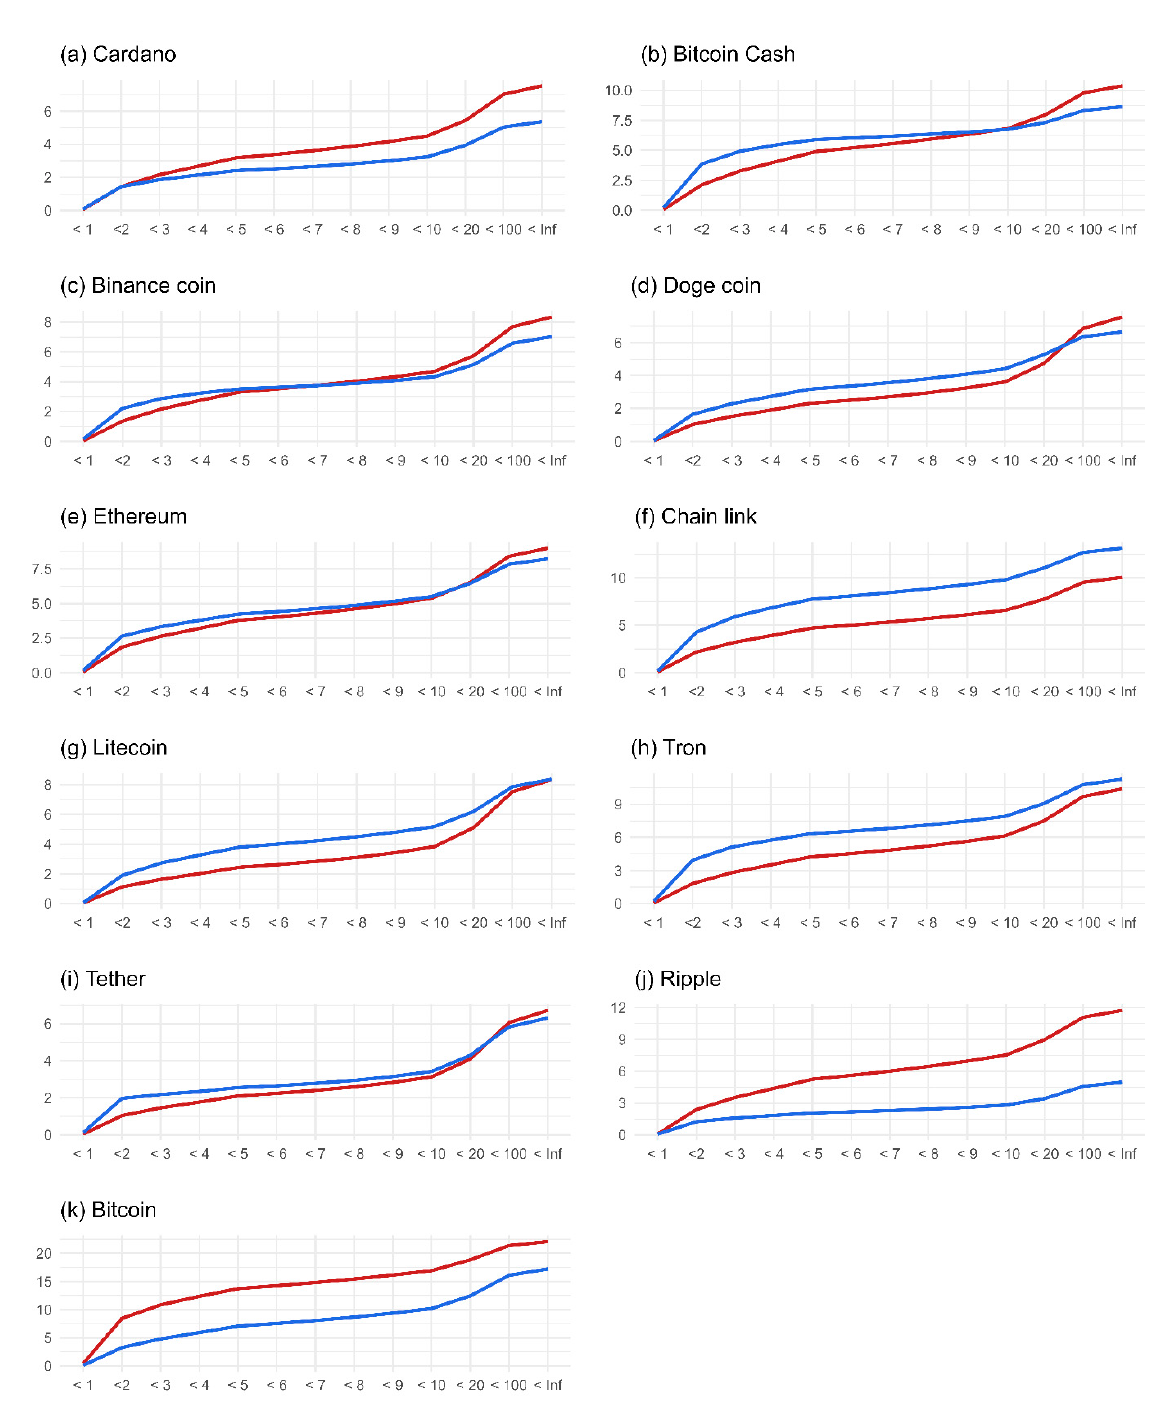
Figure A2. Short- and long-term volatility spillover from Bitcoin to altcoins during pre- and post- COVID-19 period. Note: The horizontal axis denotes the frequency in days, while the vertical axis denotes cumulative spillover index. The red and blue line shows the volatility spillover from Bitcoin to altcoins during pre-COVID-19 and post-COVID-19 period, respectively.